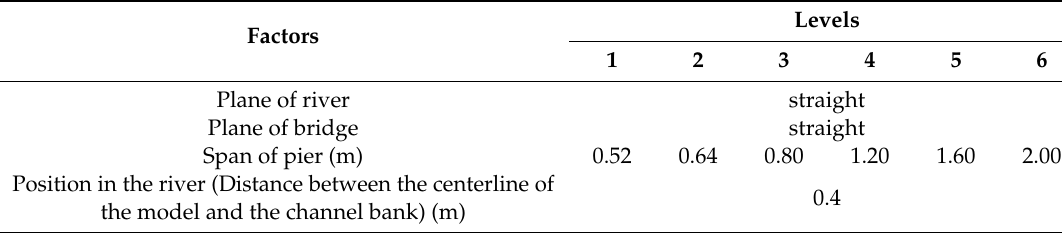
Table 4. Parameters of the model with